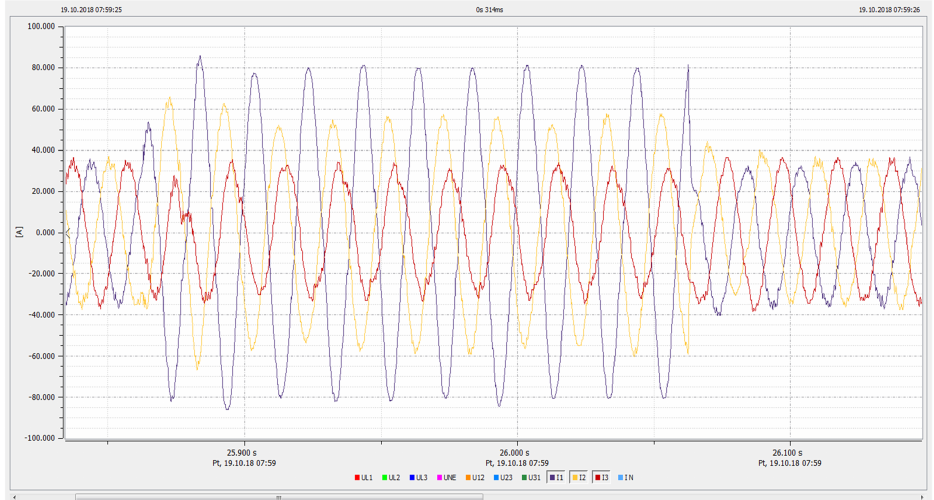
Figure 24. Waveforms of instantaneous values of the line currents of the generating unit’s block transformer at the moment of an inte-phase short-circuit in LOAD_1 (short-circuit between phases L1 and